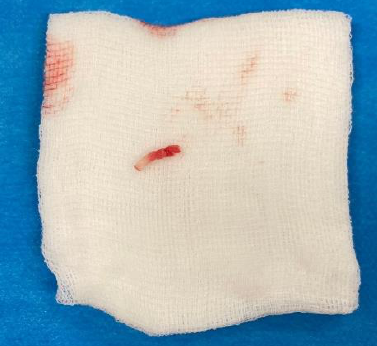
irregular oval area).